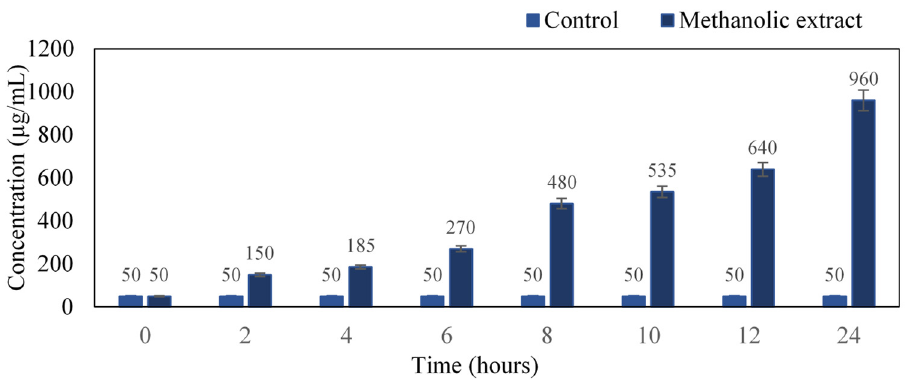
Figure 3. Quantification of protein in the cell culture from 0–24 h.